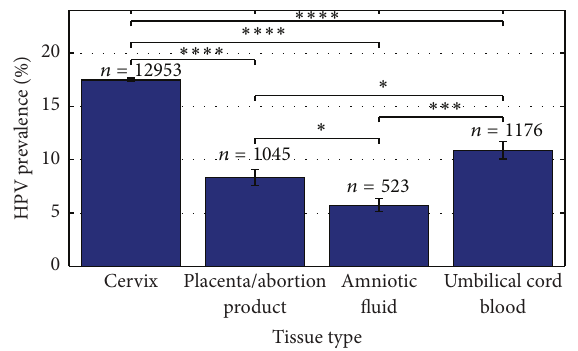
Figure 2: HPV prevalence depends on the investigated tissue type. HPVprevalenceindifferenttissuetypesofnormalpregnanciesin%. 38 studies have been included in the present analysis, 𝑁 cervix = 32 , = 9 , 𝑁 = 4 , and 𝑁 = 𝑁 placenta / abortion product amniotic fluid umbilical cord blood 7 . 𝑁 indicates number of studies included. 𝑛 indicates number of cases included. ∗ 𝑃 < 0.05 , ∗∗∗ 𝑃 < 0.001 , and ∗∗∗∗ 𝑃 < 0.0001